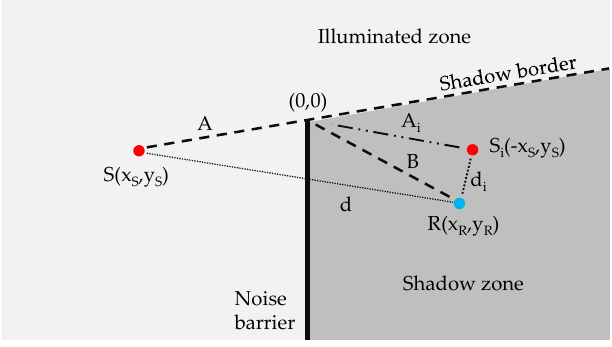
Figure 1. Elements regarding noise barriers and insertion loss. Axes are in meters (m).